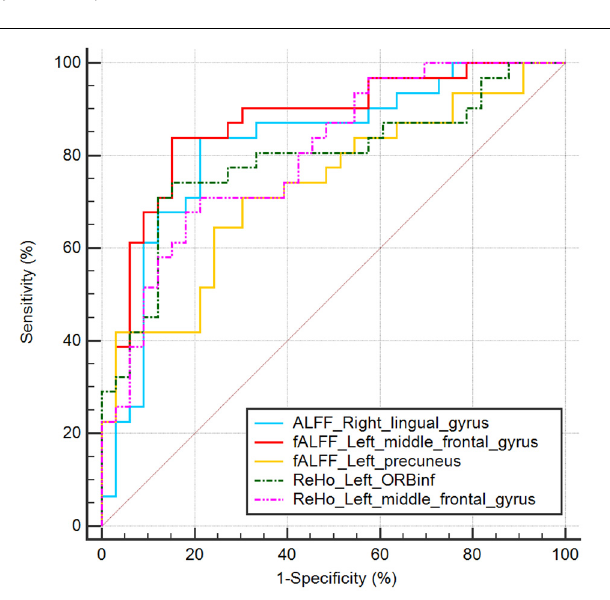
FIGURE 4 | ROC curve analysis of mean ALFF/fALFF/ReHo signal values for altered brain clusters. AUC, area under the curve; ORBinf, inferior frontal gyrus, orbital